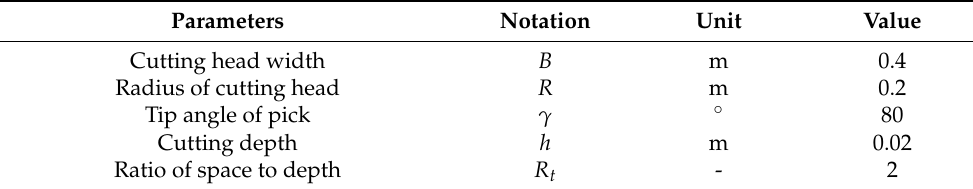
Figure 14. Structure diagram of mining vehicle.